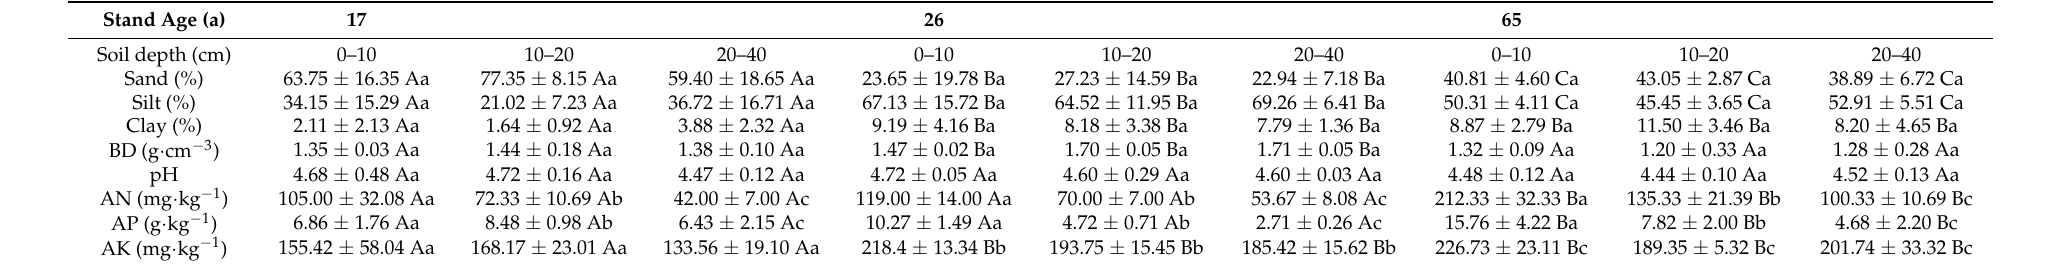
Table 2. Soil physical and chemistry properties of different stand ages. When p < 0.05, different capital letters represent differences between forest ages in the same soil layer, whereas different lowercase letters represent differences between soil layers at the same forest age. BD, bulk density; AN, alkaline hydrolysis nitrogen; AP, available phosphorus; AK, available potassium (mean ± SE, n = 3).